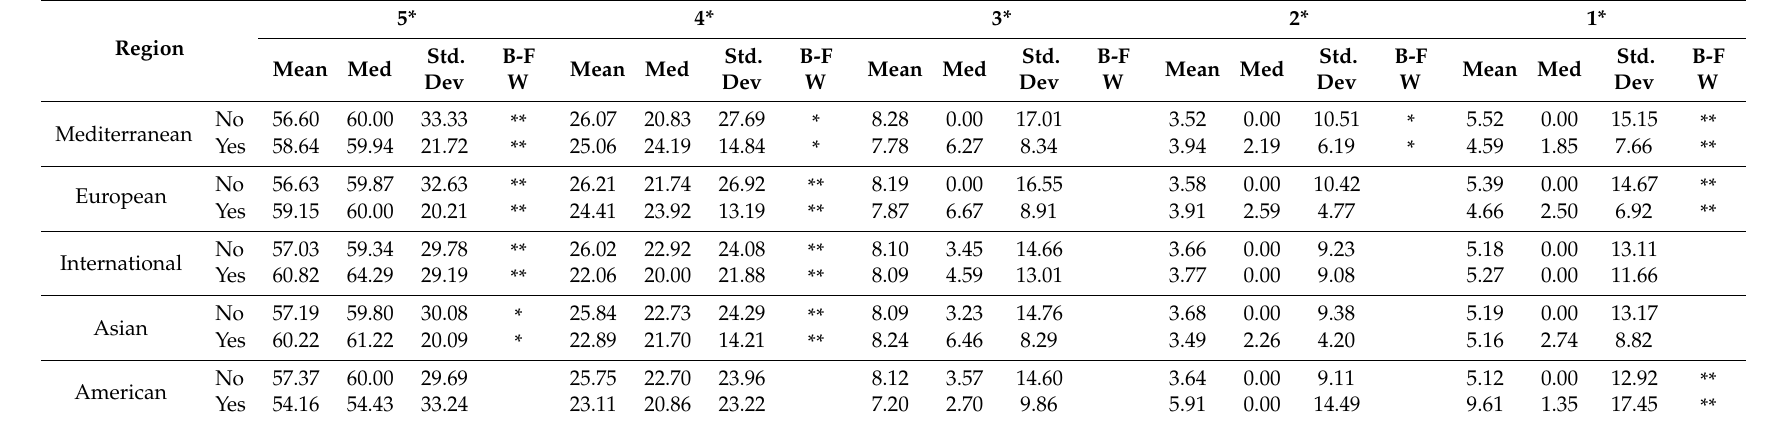
Table A3. Percent of reviews out of total restaurant reviews per score (5*–1*) and per region (Brown-Forsythe and Welch tests). N = 7558.